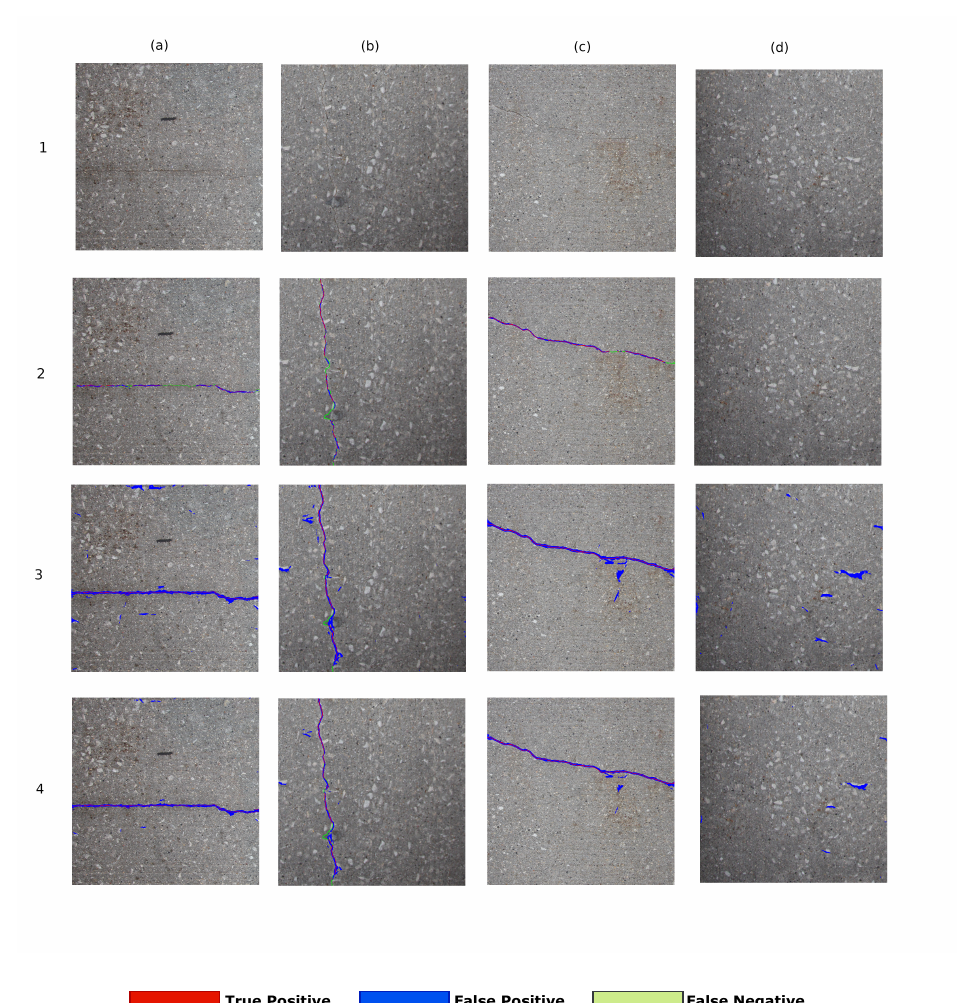
Figure 10. Comparison of different thresholds on the performance of ANet-FSM on four sample images. Columns are the tested images: ( a ) contains clear horizontal crack, ( b ) contains clear vertical crack, ( c ) contains a crack at arbitrary orientation, ( d ) non-cracked concrete image. Row 1—original image; Row 2—ANet-FSM (hi); Row 3—ANet-FSM (low); and Row 4—ANet-FSM (opt). Results will be seen clearer when zoomed